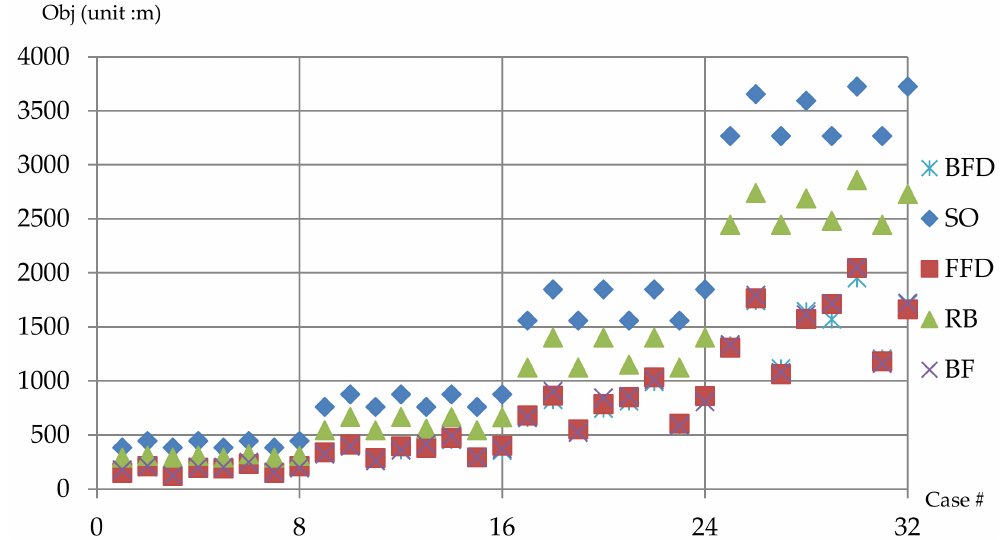
Figure 4. Comparison of five initial